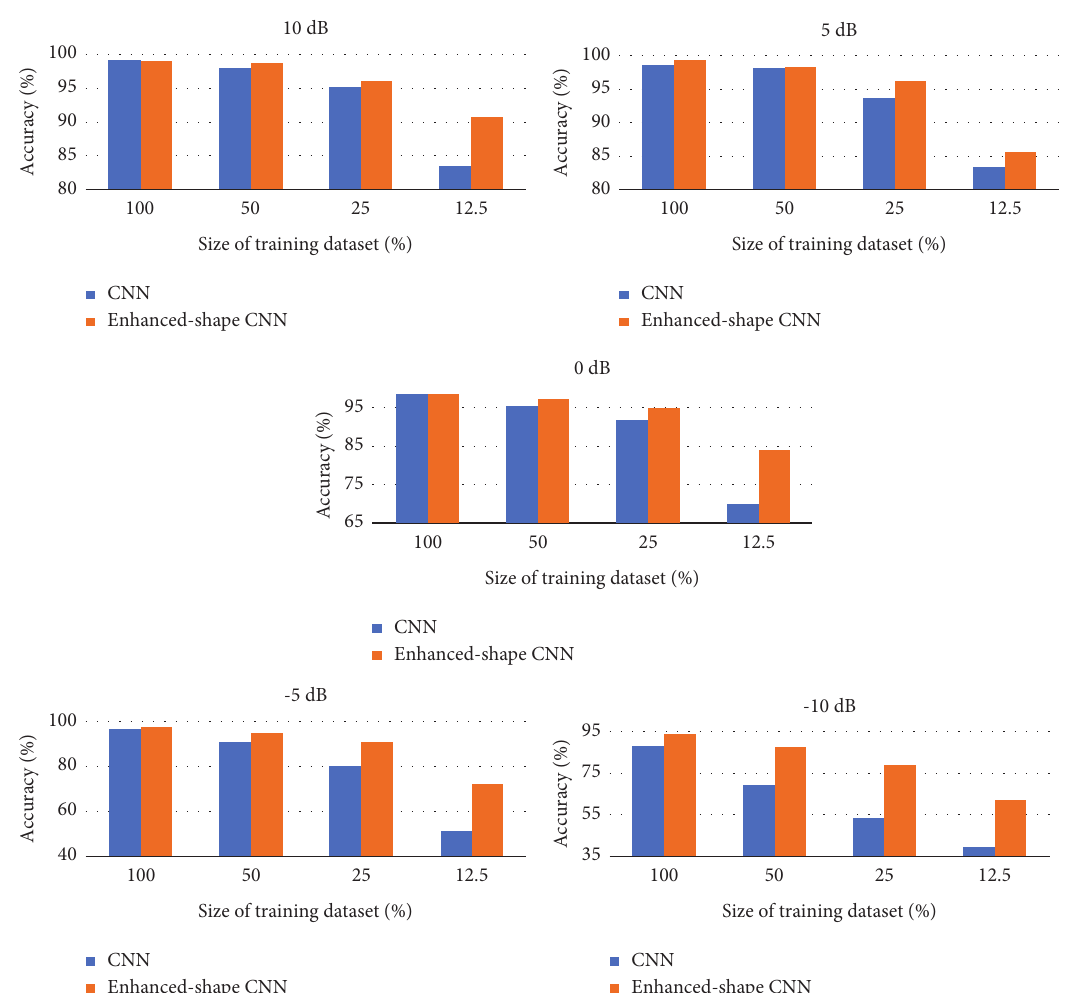
Figure 15: Performance comparison of enhanced-shape CNN and CNN under different signal-to-noise ratios.